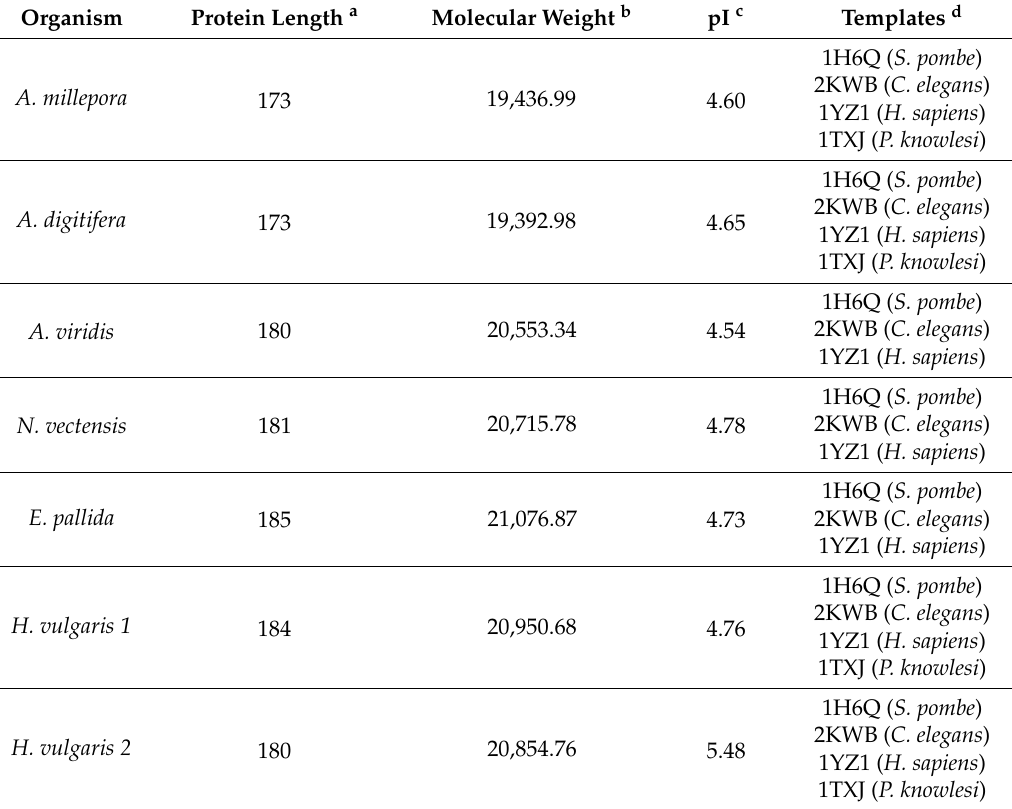
Table 3. TCTPs from